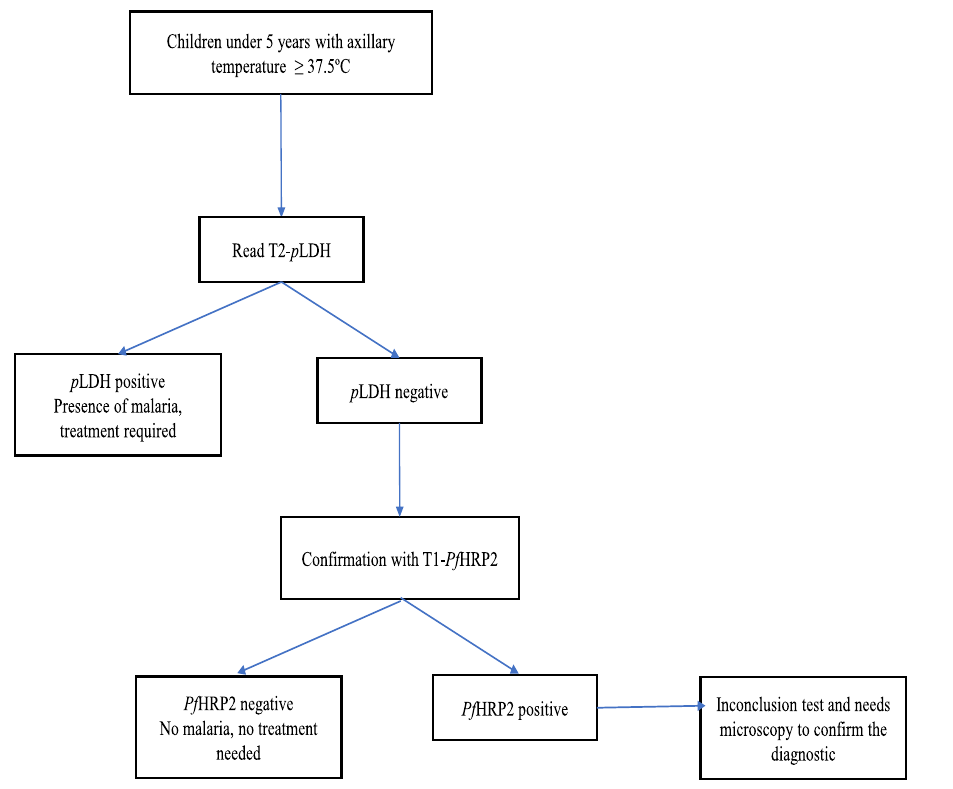
Fig 2. Proposed algorithm 2 for the diagnosis of malaria: Read T2- p LDH and confirm the T2- p LDH negative line results with T1- Pf HRP2 line.